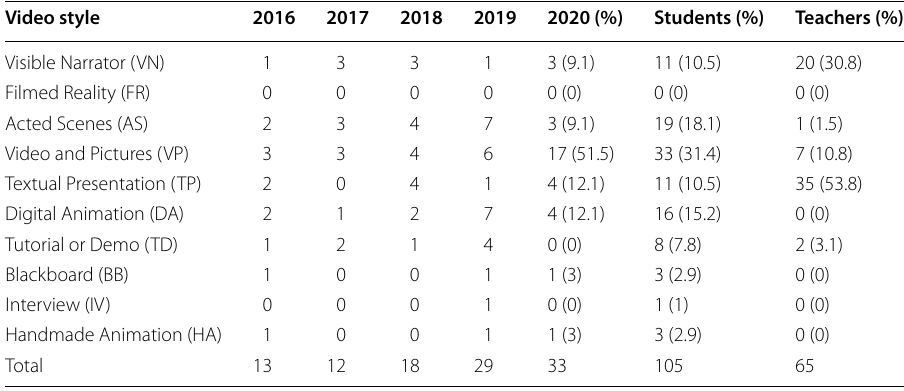
Table 2 Videos in each style made by students in different years and made by